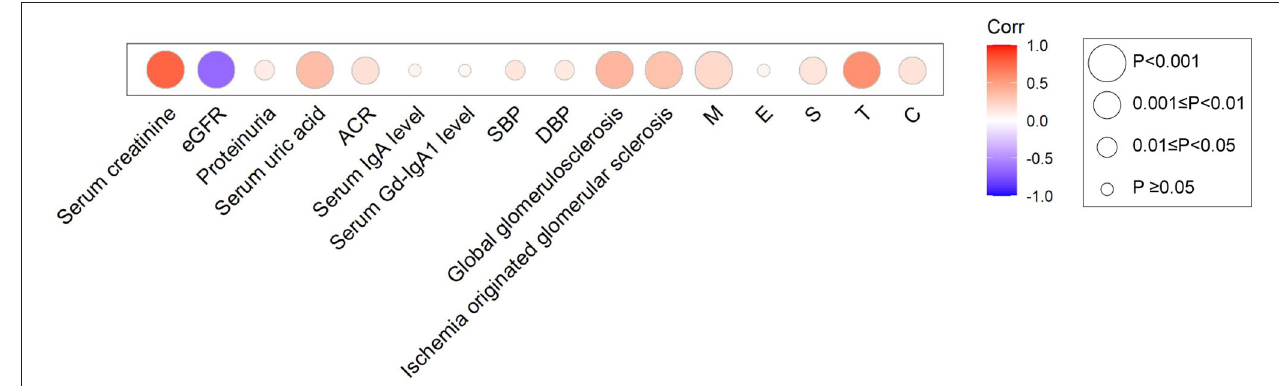
FIGURE 2 | Heatmap for the association between Hcy/eGFR ratio and clinical and pathologic manifestations in IgAN. Circles were colored by the correlation coefficients, and the size of the circle represents correlation significance level.